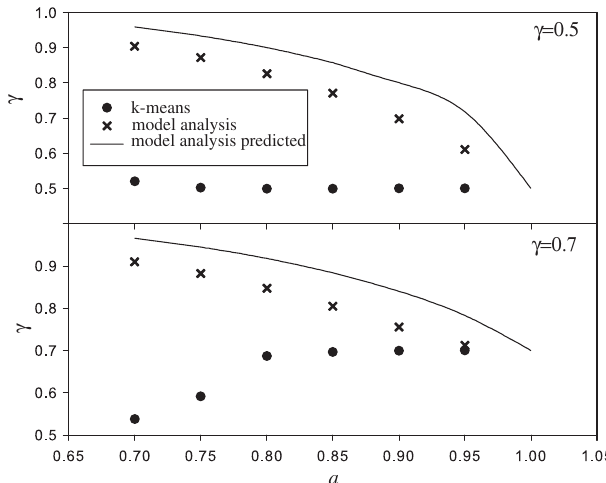
FIG. 9. Computed group population fraction (cid:1) versus a . The data used in the top figure are generated with (cid:1) ¼ 0 : 5 and the bottom figure (cid:1) ¼ 0 : 7 . The model analysis predicted line plots the theoretical prediction of the group population fraction calcu- lated from Eq. Figure 9 plots the (cid:1) computed by k -means and by model analysis against a for (cid:1) ¼ 0 : 5 and (cid:1) ¼ 0 : 7 . The theoretical